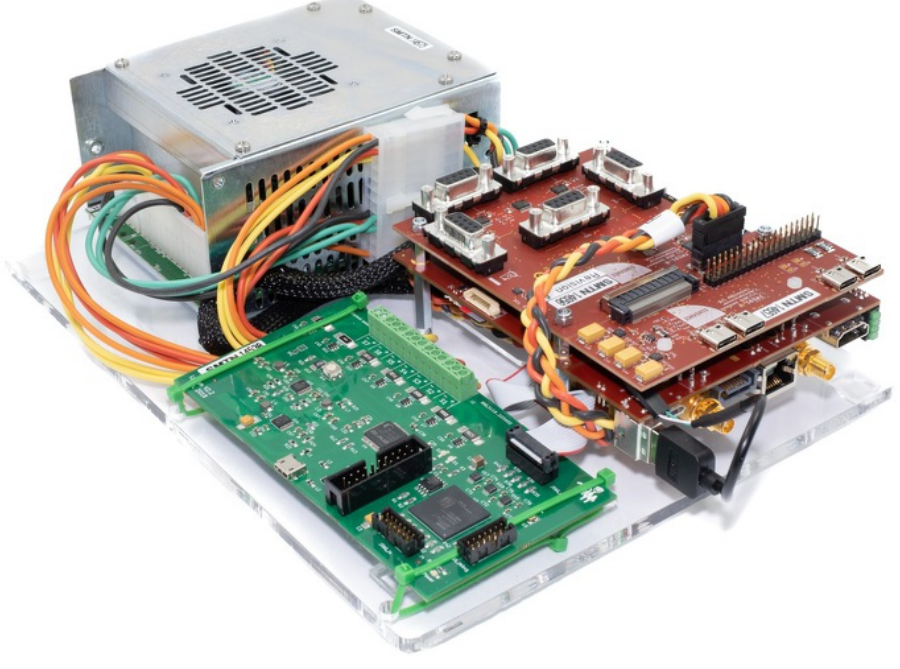
Figure A1. VSC-1 Hardware